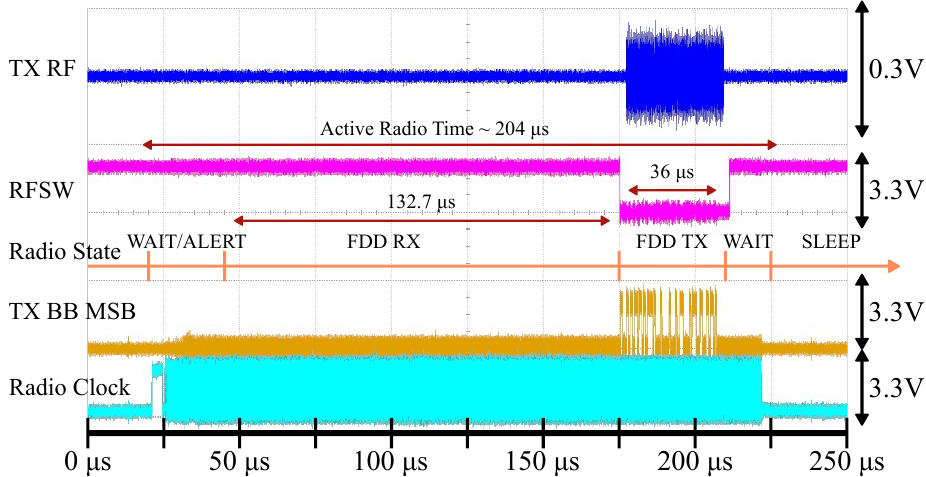
Figure 17. Duty-cycled syncword detection demonstration for T PCO = 1s. The duty-cycle controller first brings the radio to the FDD state based on the PCO counter value. After the syncword is transmitted, the radio returns to the SLEEP state. The RX window is opened for 132.7µs according to Equation (3), the TX window is 36µs ( t syncword + t latency , TX , with some margin), and the active radio time is 204µs. Signals from top to bottom: TX RF output at the antenna (blue), RF switch direction where logic high selects RX (purple), TX baseband data (MSB) output of the chip (yellow), AD9364 clock